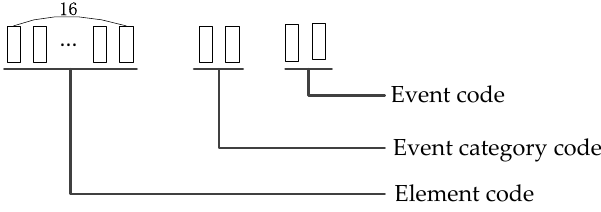
Figure 4. Code structure of the grid events in the railway transportation system.